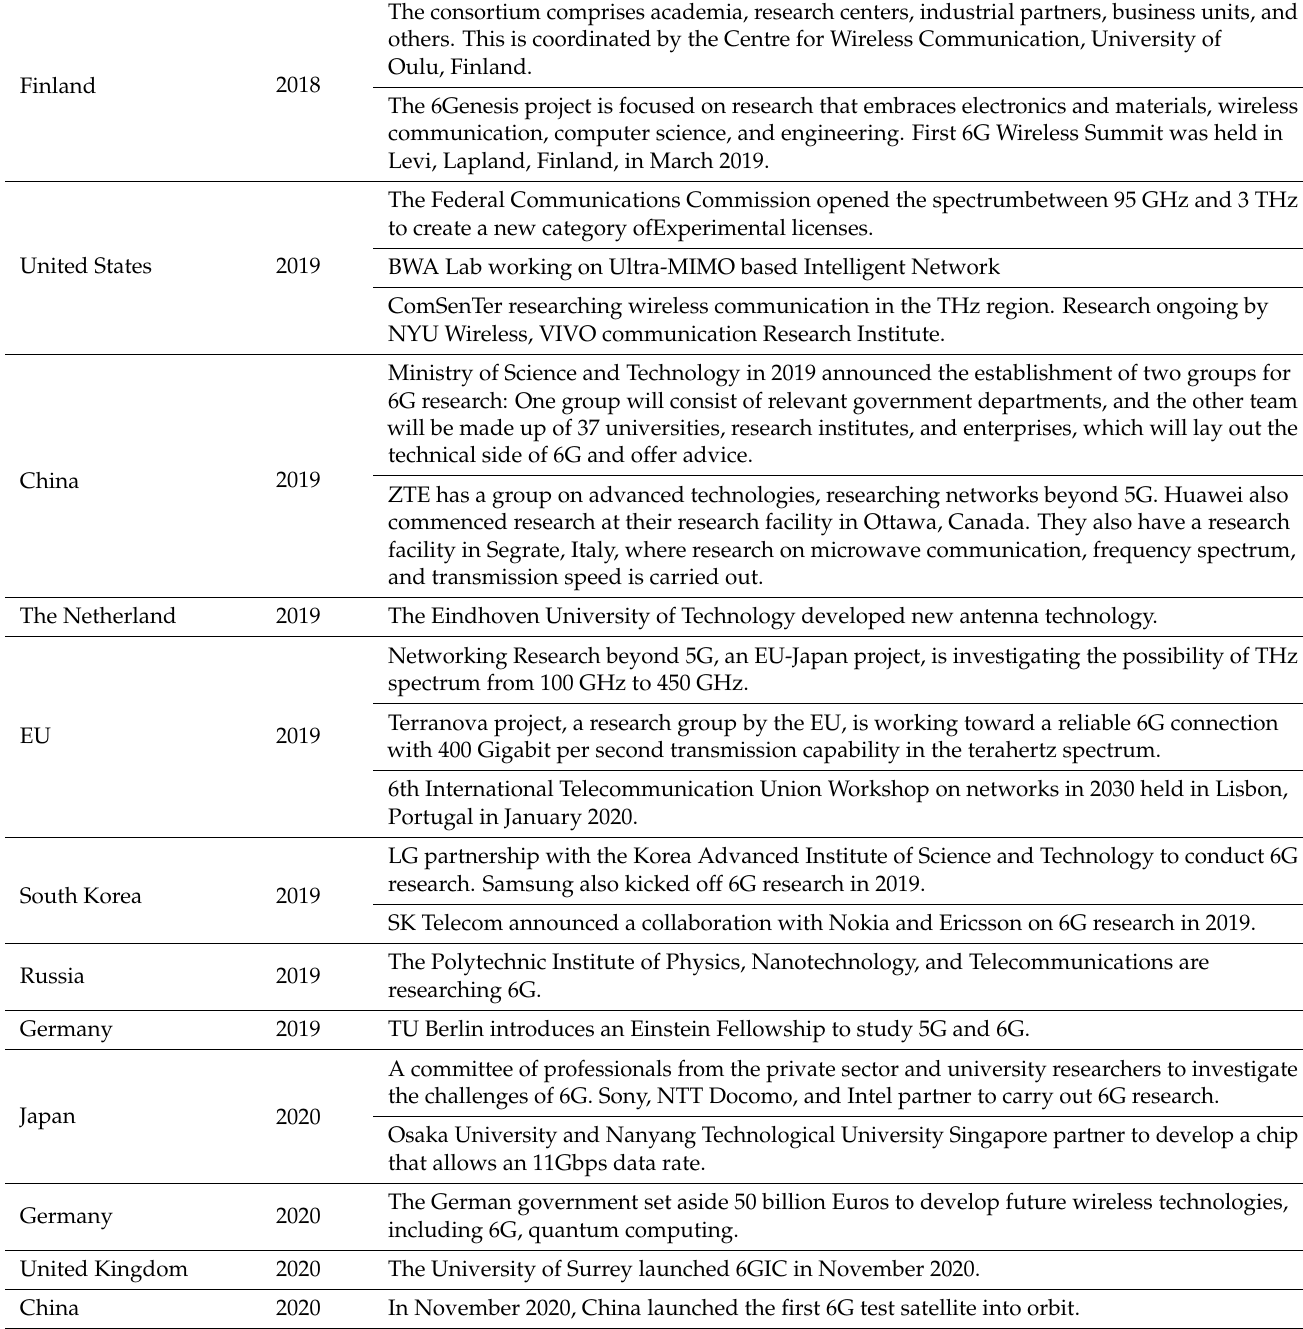
Table 7. 6G research in selected countries and